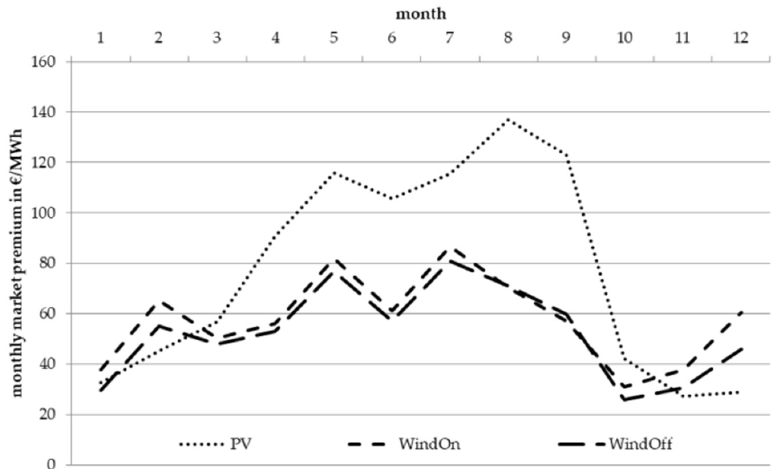
Figure 5. Development of the market premium for PV, wind onshore and wind offshore in the extended scenario.